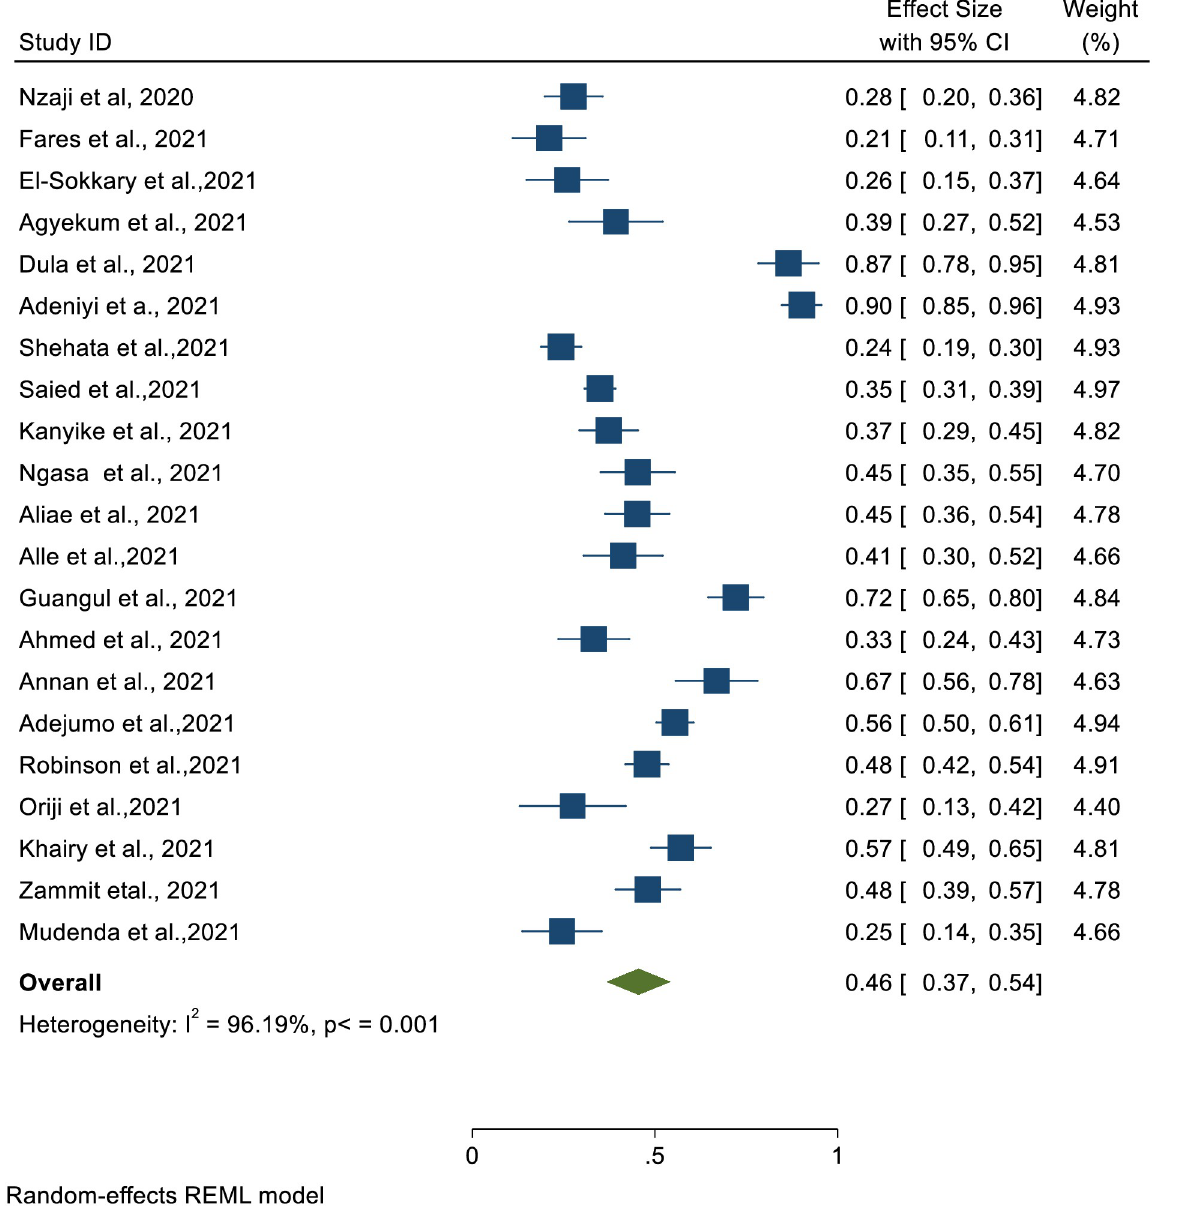
Fig 2. COVID -19 vaccine acceptance rate among HCWs in